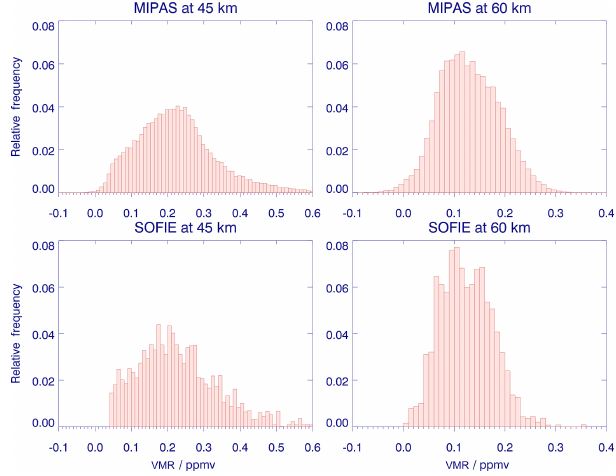
Figure 10. Relative frequency of vmr values of MIPAS (upper line) and SOFIE (bottom line) at 45km (left column) and 60km (right